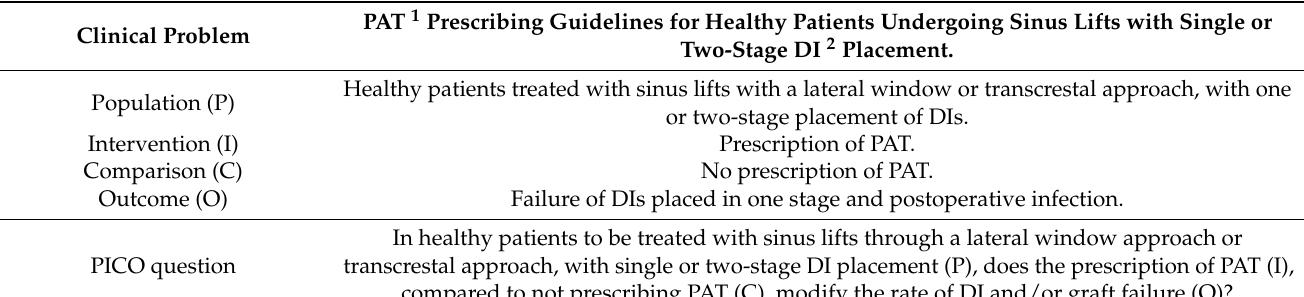
Table 3. PICO question 3.